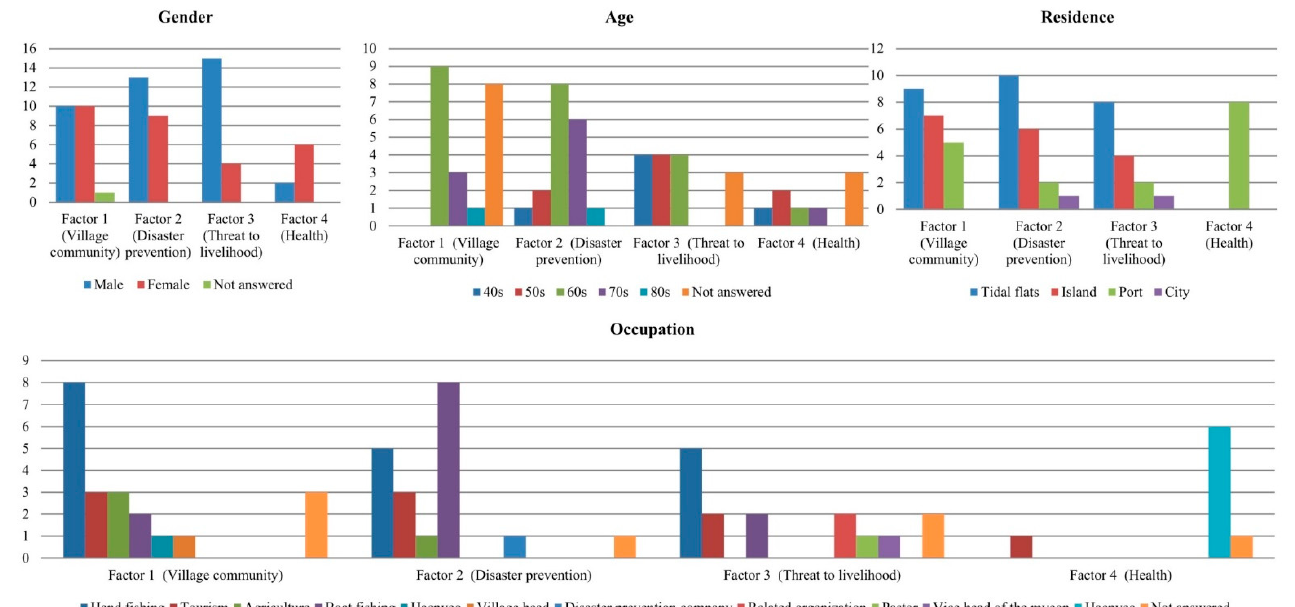
Figure 3. Distribution of stakeholders by factors.